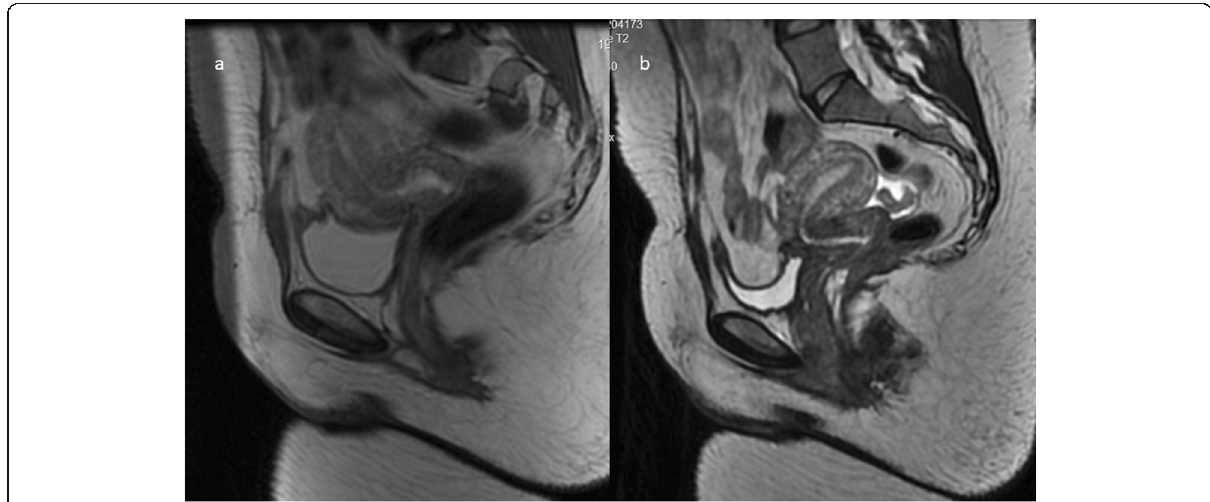
Fig. 10 A 20-year-old woman with a history of synovial sarcoma of the right inguinal region, followed up routinely for oncological indications, 2 months ( a FSE/T2WI) and 5 months ( b CUBE/3D/T2WI) after C-section. The post-C-section scar is not visible; however, adhesions between the uterus and the bladder wall can be suspected ( a ) and are confirmed 3 months later, not only by the loss of the fat plane in between but also